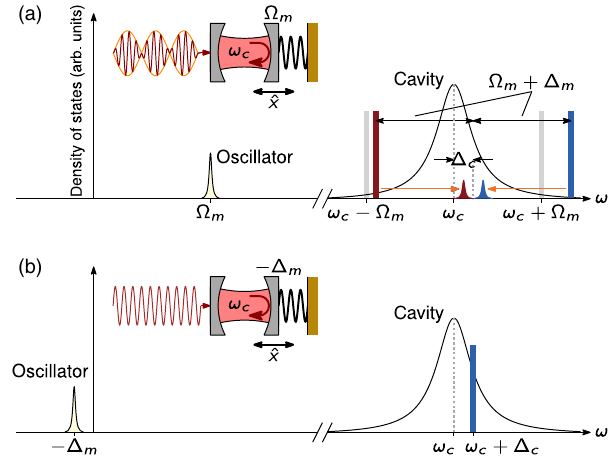
FIG. 1. Pumping scheme leading to two-tone instability. (a) Frequency-space representation of optical backaction-evading (BAE) measurement using two-tone pumping. An optomechan- ical system is pumped with two pumps that are placed on the lower and upper motional sideband of the cavity (shown in gray). Two detuning errors are introduced, due to imperfect knowledge of the mechanical oscillator frequency ( Δ ), and due to imperfect m symmetric spacing around the cavities ’ resonance frequency ω , c as expressed by Δ . Also shown are the mechanical resonance at c frequency Ω and the scattered mechanical sidebands. The inset m shows an optomechanical system: a mechanical oscillator (posi- tion coordinate ˆ x ) that is the moving mirror of a Fabry-Perot cavity and that is coupled to the cavity mode by radiation pressure. (b) An equivalent system, in which the two-tone pumping is mapped to a Hamiltonian that exhibits the same dynamics as (a), consisting of a single continuous pump field Δ applied at ω and with the mechanical oscillator frequency c þ c → − Δ obeying the substitution Ω . Note that Δ and Δ have m m c m been exaggerated for